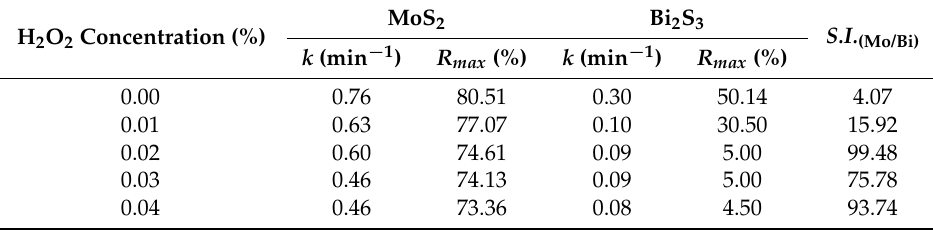
Table 2. Model parameters of flotation kinetics obtained under different H 2 O 2 concentrations at pH 8. H 2 O 2 Concentration